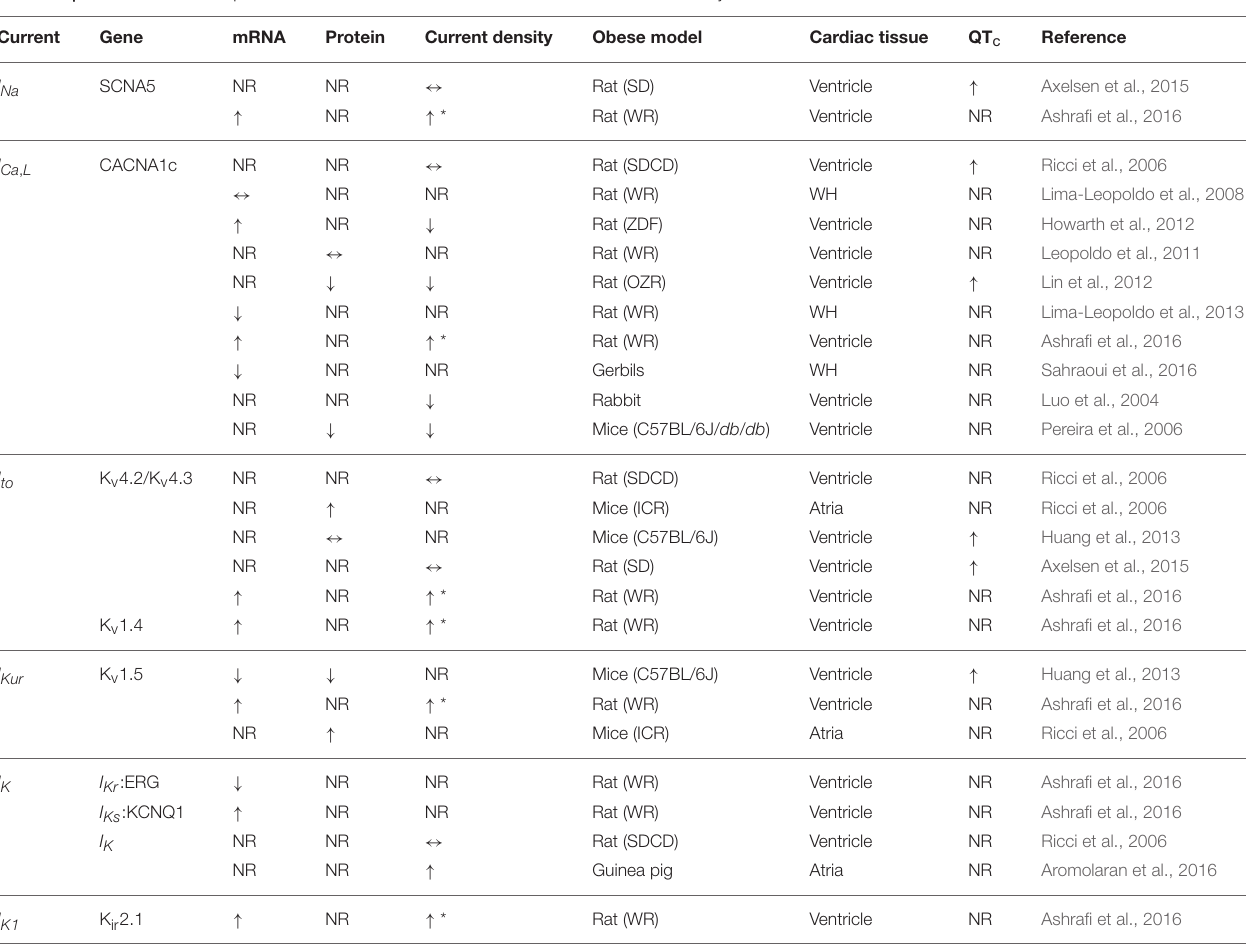
TABLE 1 | Altered functional expression of ion channels in animal models of HFD induced